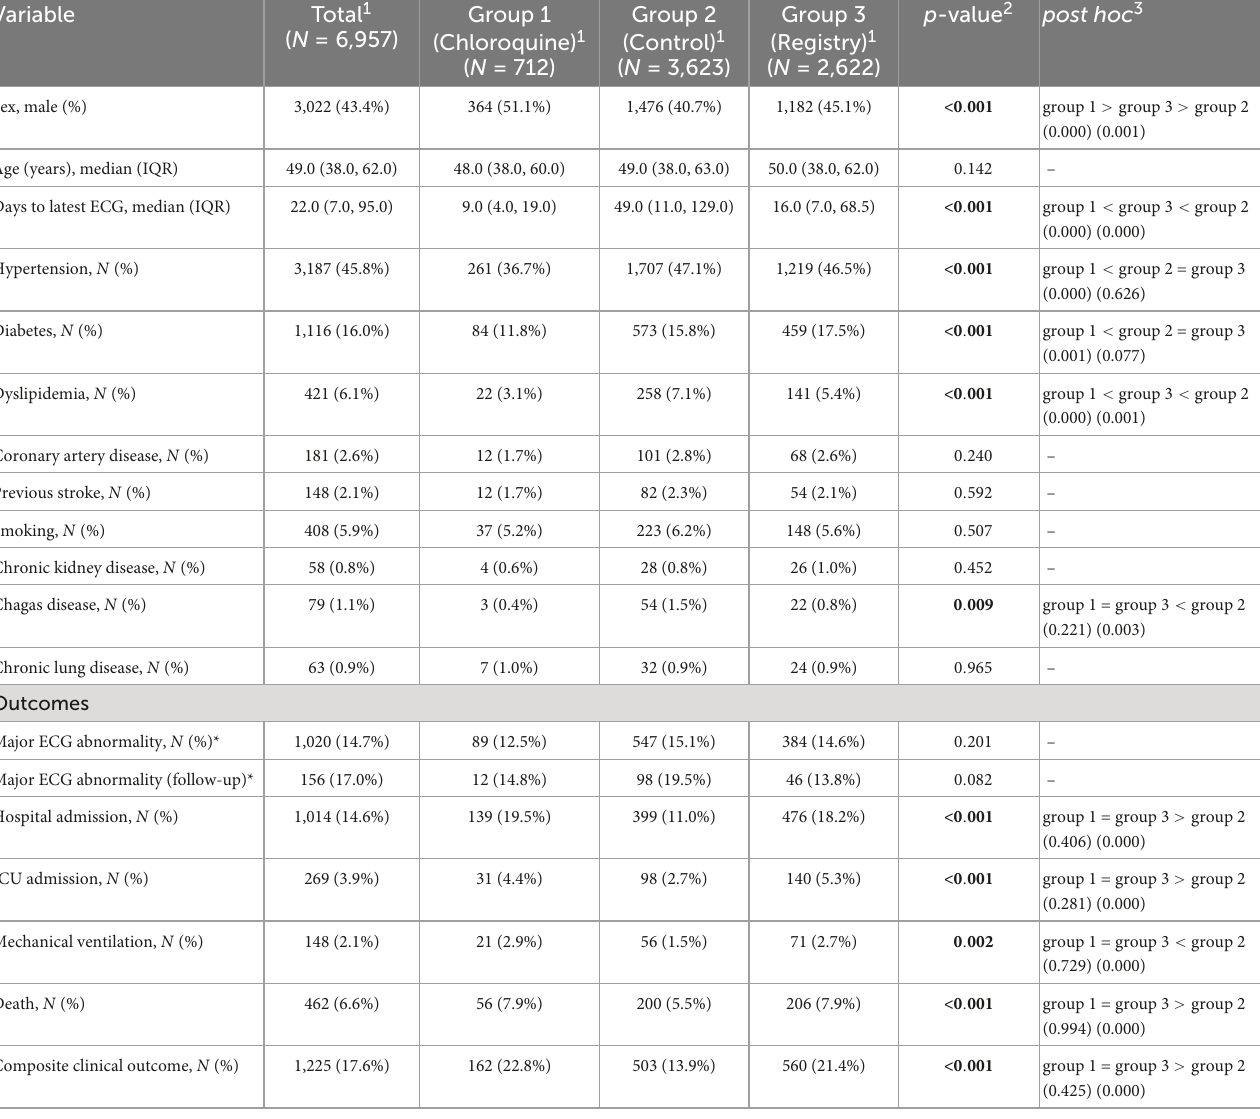
TABLE 1 Baseline characteristics and rates of clinical outcomes of all patients included in the study (at least 1 ECG and clinical data entered in the online system), combining phone and administrative follow-up data, and comparison between treatment groups.